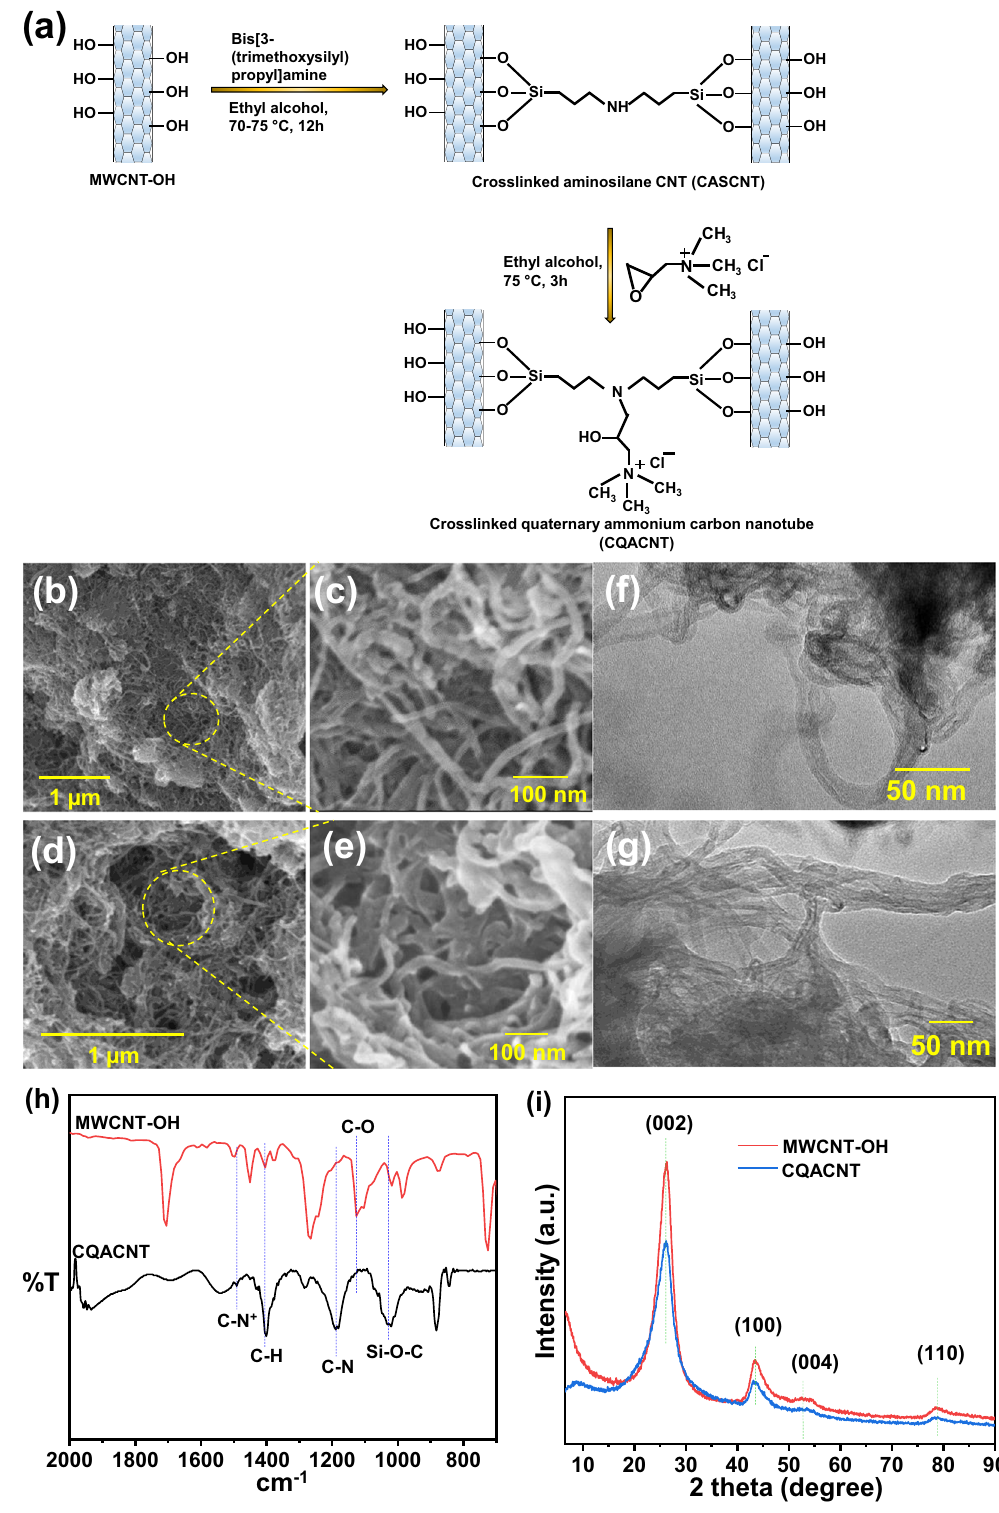
Fig. 1 Synthesis and morphological and spectroscopic studies of cross-linked quaternary ammonium carbon nanotube (CQACNT). a Schematic reaction route for the synthesis of CQACNT; b SEM image of MWCNT-OH; c high-resolution SEM image of MWCNT-OH; d SEM image of CQACNT; e high-resolution SEM image of CQACNT; f TEM image of MWCNT-OH; g TEM image of CQACNT; h FT-IR spectra of MWCNT- OH and CQACNT; i XRD pattern of MWCNT-OH and